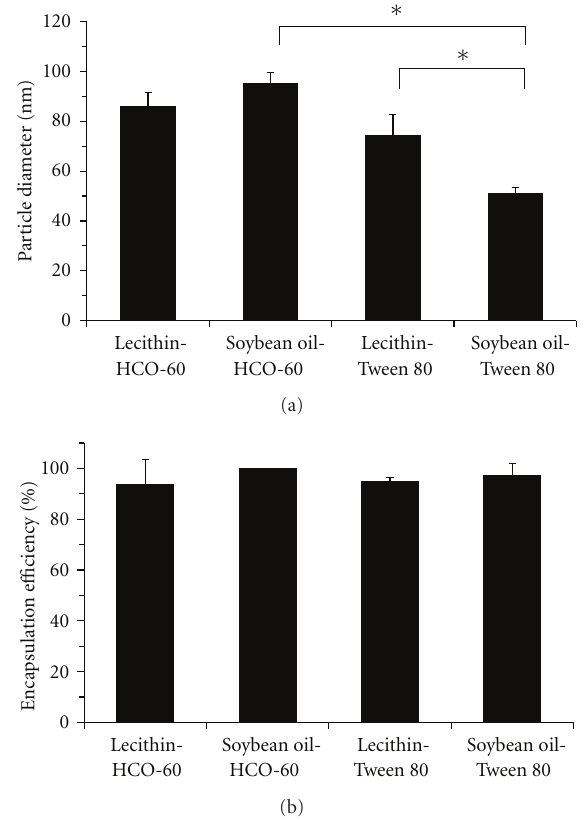
Figure 3: E ff ect of lipid type on the particle diameter (a) and percent incorporation e ffi ciency (% IE) (b) of curcumin lipid nanoemulsions. Formulation: 1, 2, 3, and 4 in Table 1. Data are represented as the mean ± standard deviation of 3 independent experiments ( n = 3). ∗ Significantly di ff erent ( P < 0 . 05) by one-way ANOVA.